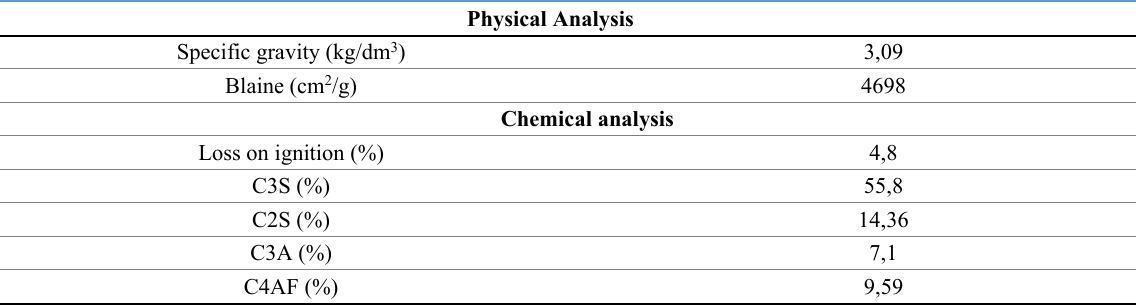
Figure 1. Transmission electron microscopy (TEM) on the CNTs Table 1. Physical and chemical characterization of ordinary Portland